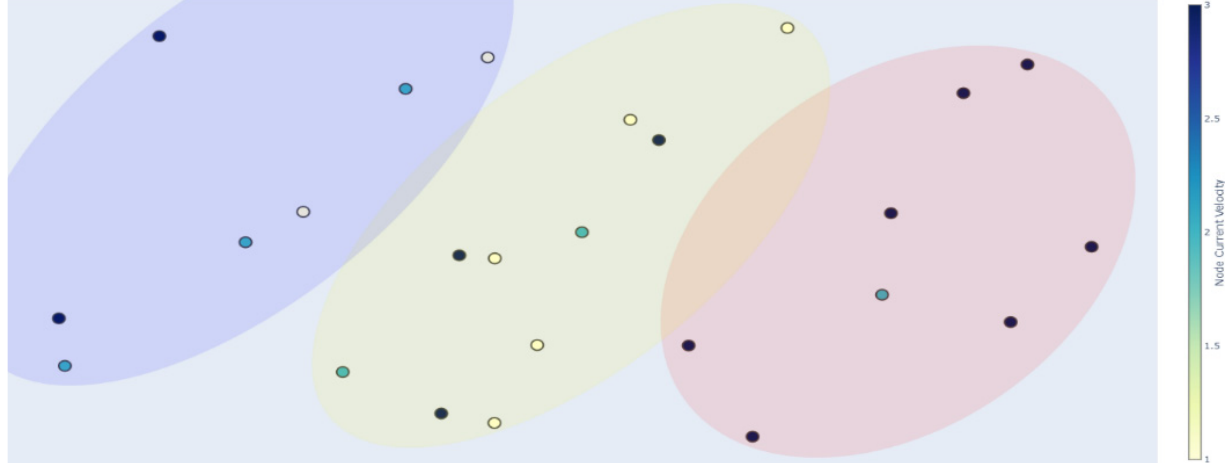
Figure 6. Clustering results of case study 1 based on distance and current information. Table 2. Evaluation of clustering methods for CS2. The best evaluation score is shown in bold.